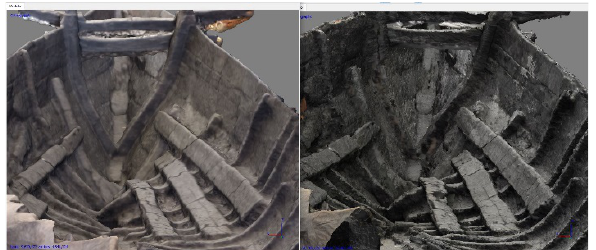
Figure 11. The comparison between the meshes from OSMO (on left) and Nikon (right): the boards of the floor and the ribs in the model generated by OSMO are more rounded and